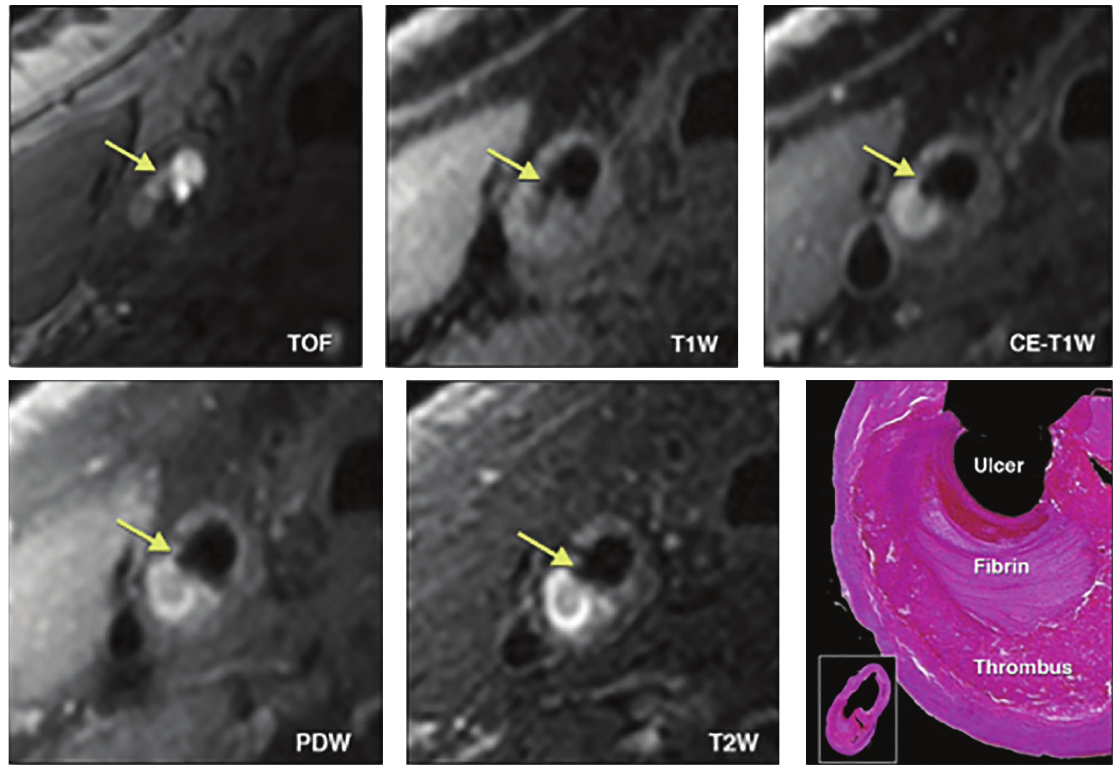
Figure 2: Morphologic characteristics of carotid artery atherosclerosis using MRI. 3-T magnetic resonance imaging (MRI) of a plaque in the right common carotid artery demonstrates fibrous cap rupture with ulcer formation (yellow arrows). The crescent-shaped high-signal region in the proton density-weighted (PDW), T2-weighted (T2W), and contrast enhanced T1-weighted (CE-T1W) images corresponds to a region of thrombus formation, shown on the matched histology section (hematoxylin and eosin stain). Reprinted with permission from Chu et al.